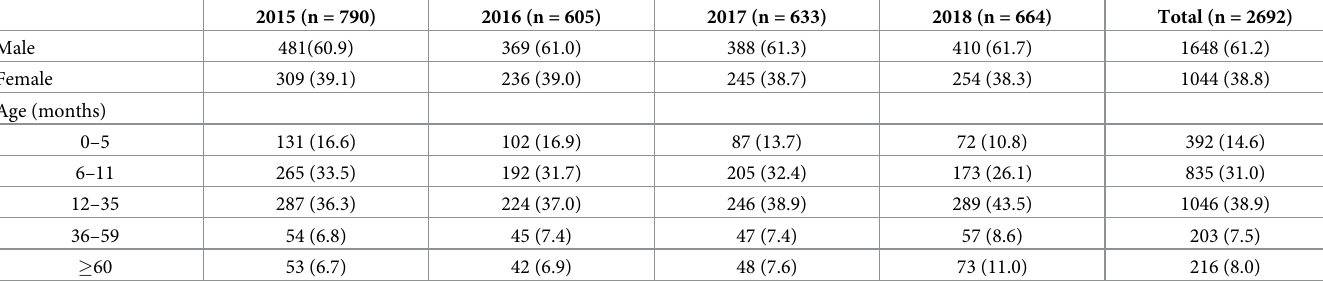
Table 1. Demographic characteristics of enrolled outpatients with acute diarrhoea in Shanghai from 2015 to 2018 [n (%)].